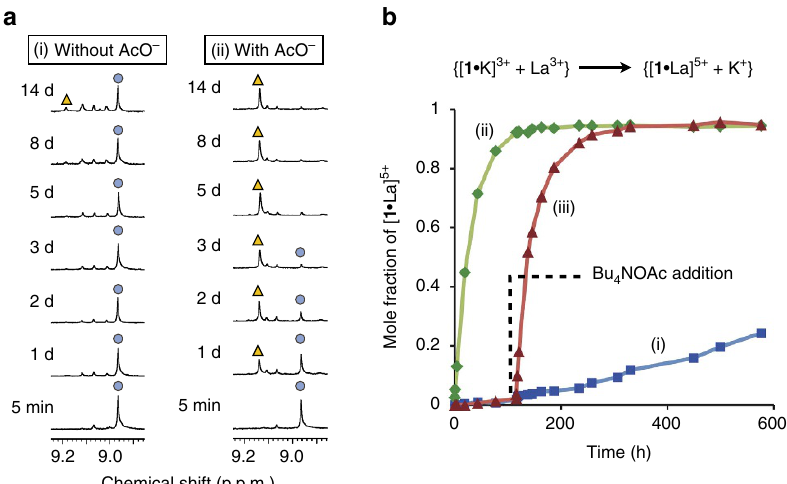
Figure 3 | Time course analysis of guest exchange from [1 (cid:2) K] 3 þ to [1 (cid:2) La] 5 þ . ( a ) Changes of the imine signals in the 1 H NMR spectra (blue circle: K þ complex and yellow triangle: La 3 þ complex) in the absence/presence of tetrabutylammonium acetate (1.0mM, CD 3 OD, 25 (cid:2) C). ( b ) Plots of mole fractions of [ 1 (cid:2) La] 5 þ versus time after addition of K þ and La 3 þ .